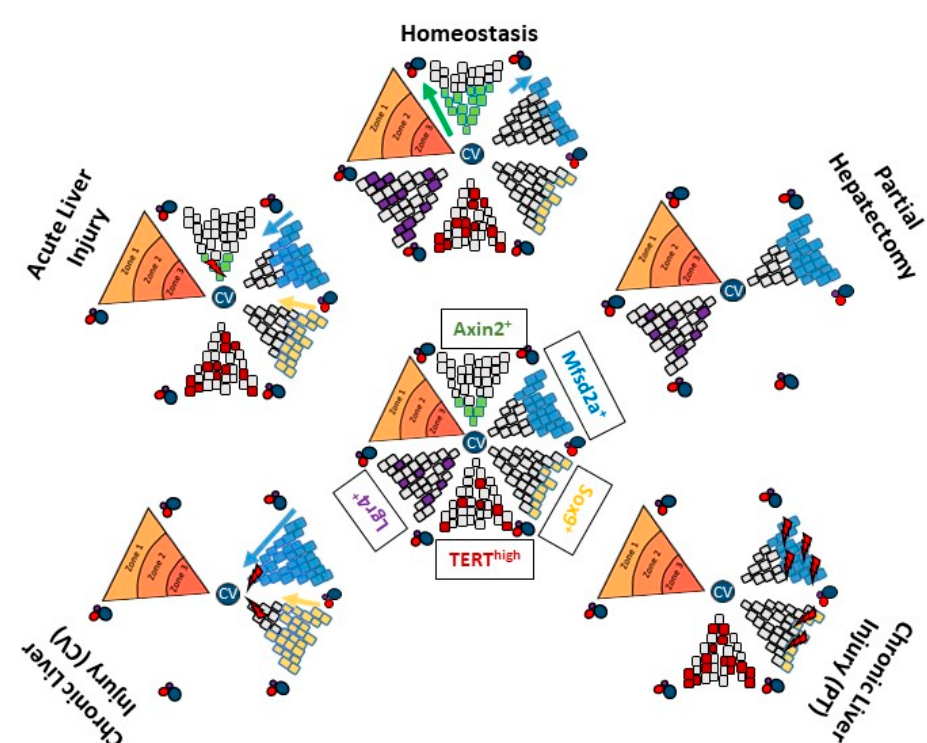
Figure 1. The hepatocyte subpopulations. Graphical summary of the distinct populations of hepatocytes and their contribution to parenchymal regeneration in different liver injuries. Represented at the center of the figure are the populations as traced at the beginning of any experiment. Mfsd2a: major facilitator super family domain containing 2a; Sox9: SRY-related high mobility group (HMG) box transcription factor 9; TERT: telomerase reverse transcriptase; Lgr4: Leucine-rich repeat-containing G protein-coupled receptor 4; CV: central vein; PT: portal tract.